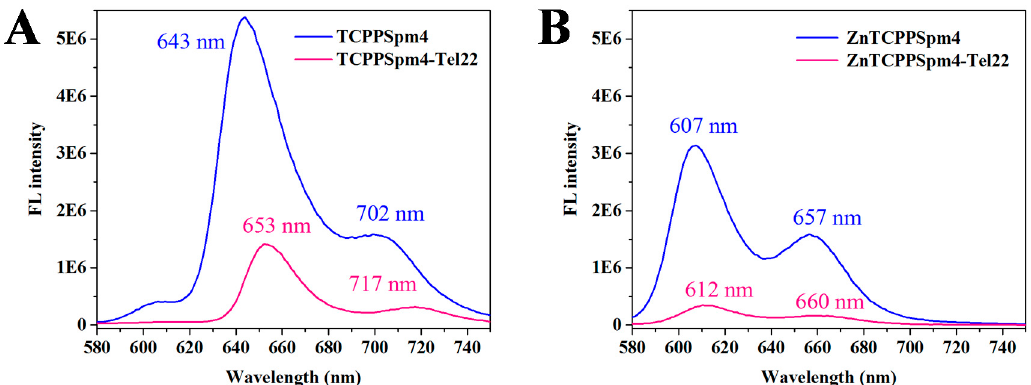
Figure 5. Steady-state fluorescence emission spectra for ( A ) 0.33 µM TCPPSpm4 alone and in the presence of 19.5 fold excess of Tel22 and ( B ) 0.47 µM ZnTCPPSpm4 alone and in the presence of 9.1 fold excess of Tel22. Note, for the ease of comparison, the data were scaled to 1 µM porphyrin. 2.4. FRET Studies Indicate that Both Porphyrins Have Exceptional Stabilizing Ability and Modest Selectivity